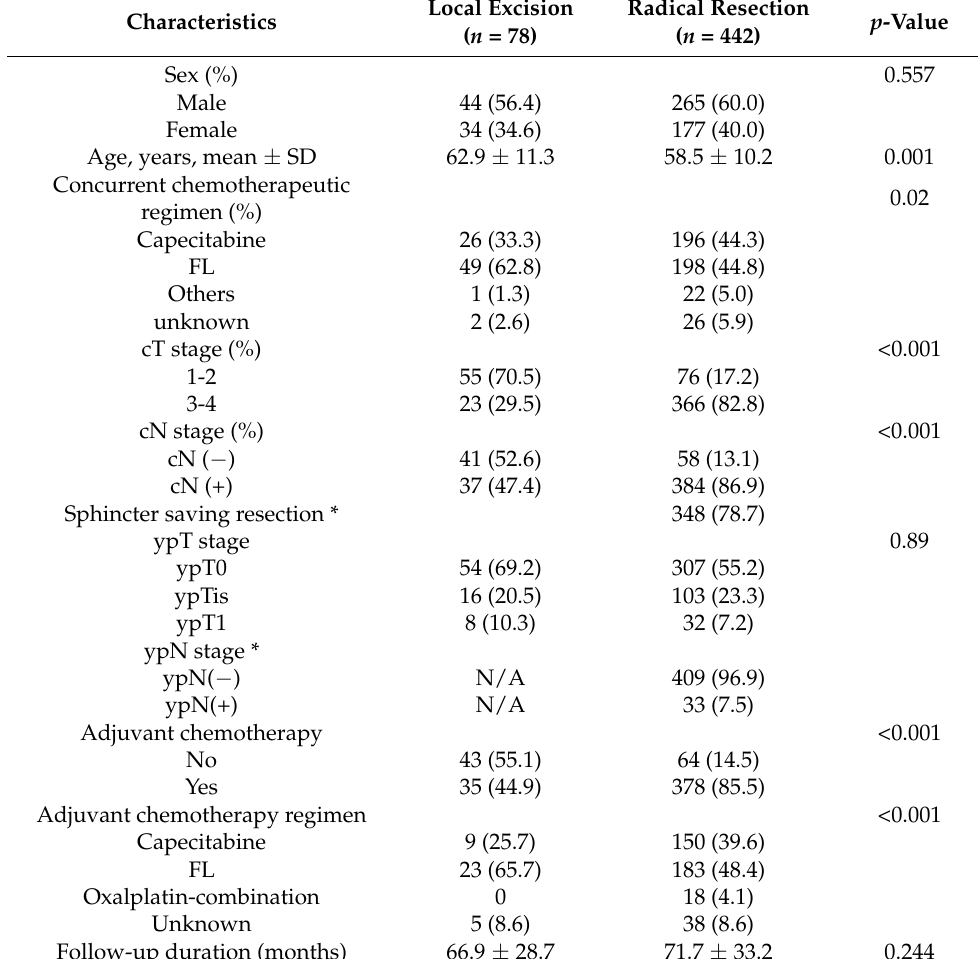
Table 1. Clinicopathological